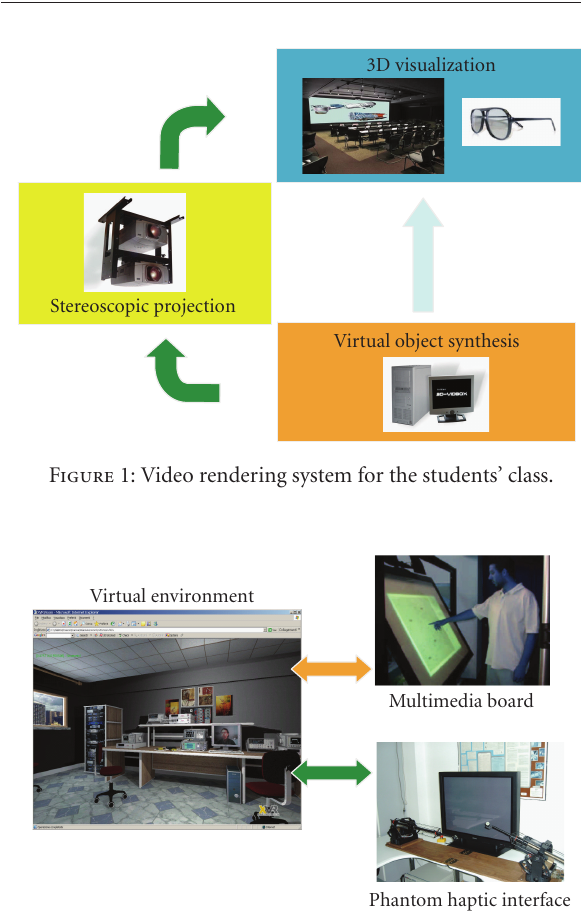
Figure 2: Input devices.